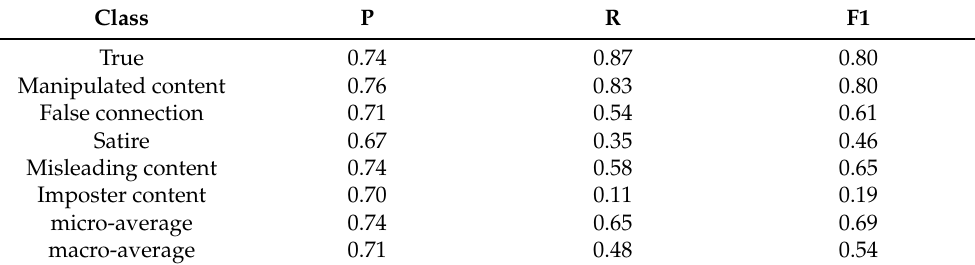
Table 5. Results of CNN with dynamic Glove vectors.